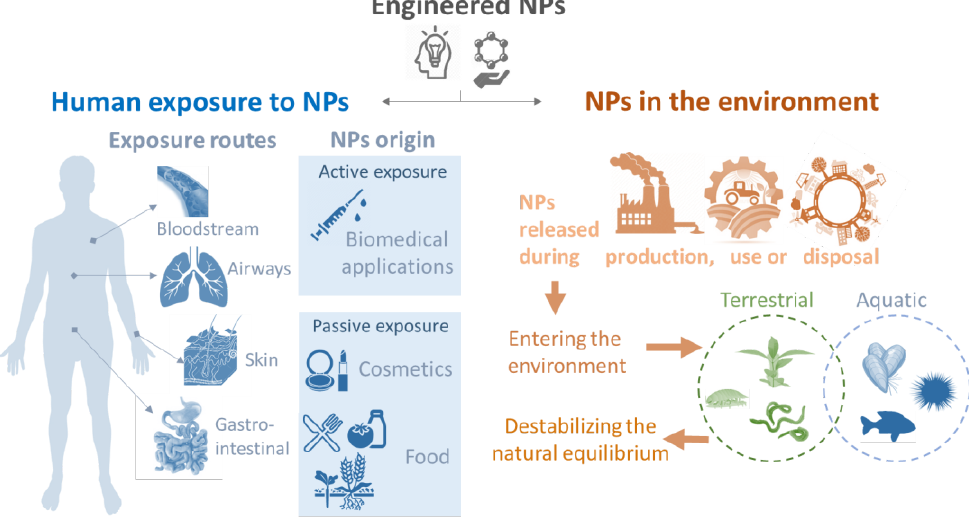
Figure 1. The different exposure pathways of engineered NPs that can interact with human or environmental species.